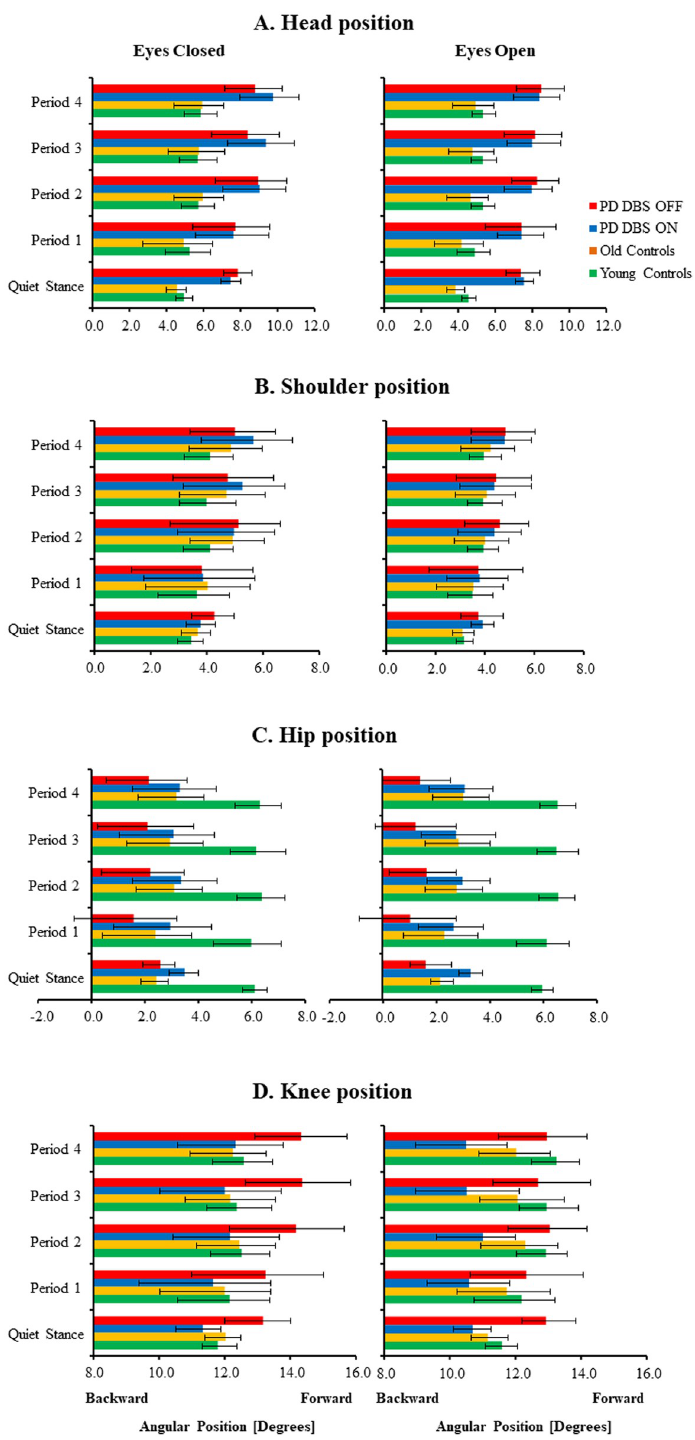
Fig 1. Body posture during different phases of the posturography tests. Results are presented for tests with eyes closed and eyes open in patients with PD with DBS OFF; in patients with PD with DBS ON; in old and in young controls. Fig 1A present the head position, Fig 1B the shoulder position, Fig 1C the hip position and Fig 1D the knee position. The values are in degrees, where the size of the bars represent group mean values of the posture and the whiskers mark respectively group mean values of range forward (increasing positive) and range backward (decreasing positive). All subjects utilize an increasing body leaning forward during balance perturbations, but this change was effectuated stronger in both control